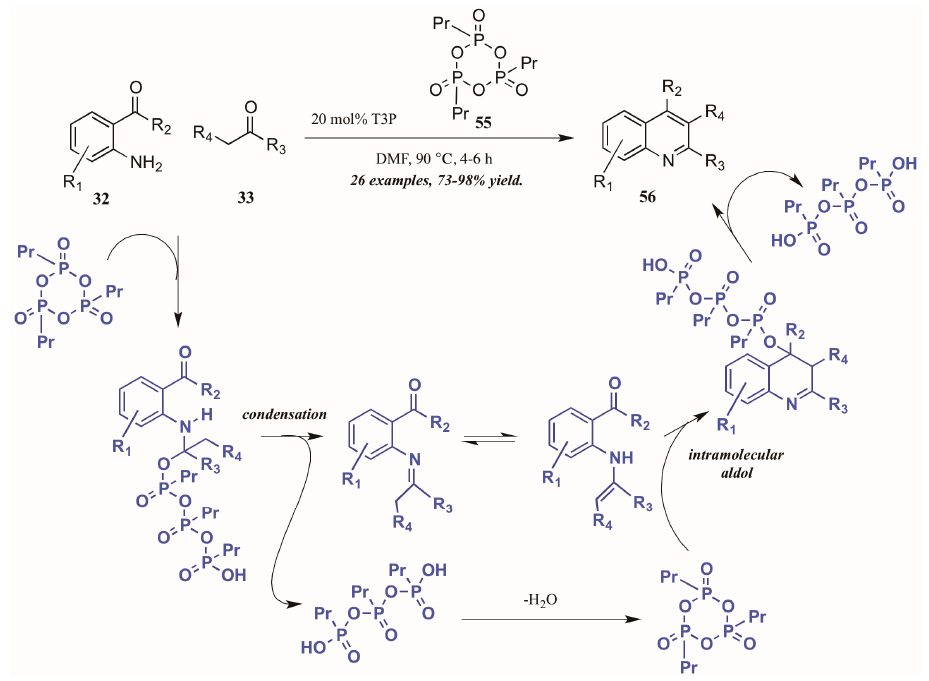
Figure 26. Friedländer quinoline synthesis via peptide coupling reagent.